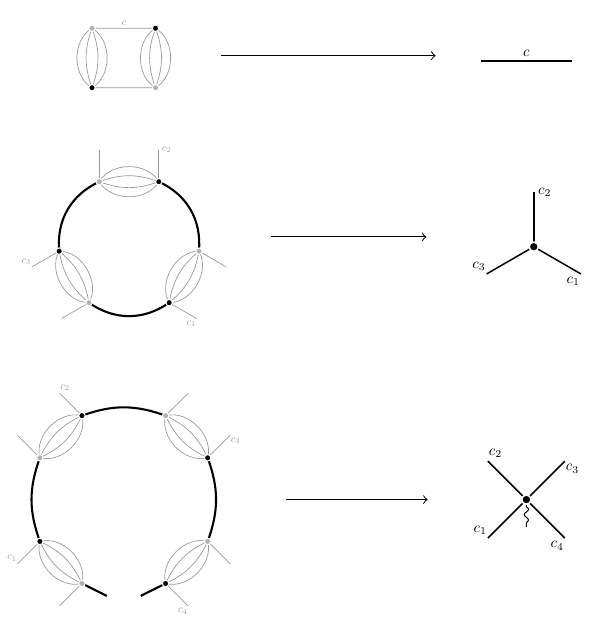
Figure 5: Bijection between coloured graphs and coloured maps – Feynman